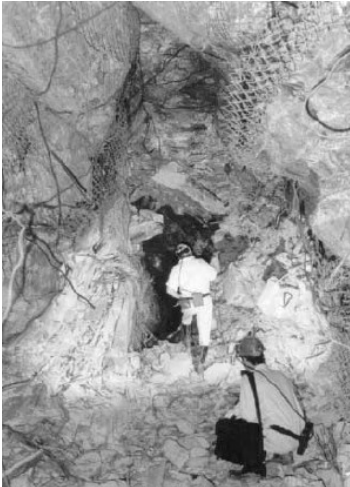
Figure 2. Adverse haulage conditions at Hartebeestfontein Gold Mine in South Africa caused by slow time-dependent deformation processes in the rock (from Malan 2002 [3,4]).